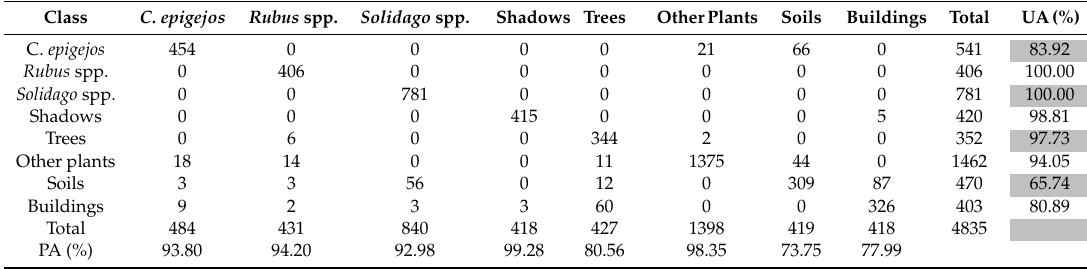
Table 3. Confusion matrix of the SVM classification with 30-MNF bands and the 300 pixel training set (Kappa coe ffi cient = 0.89, OA = 91.21%).